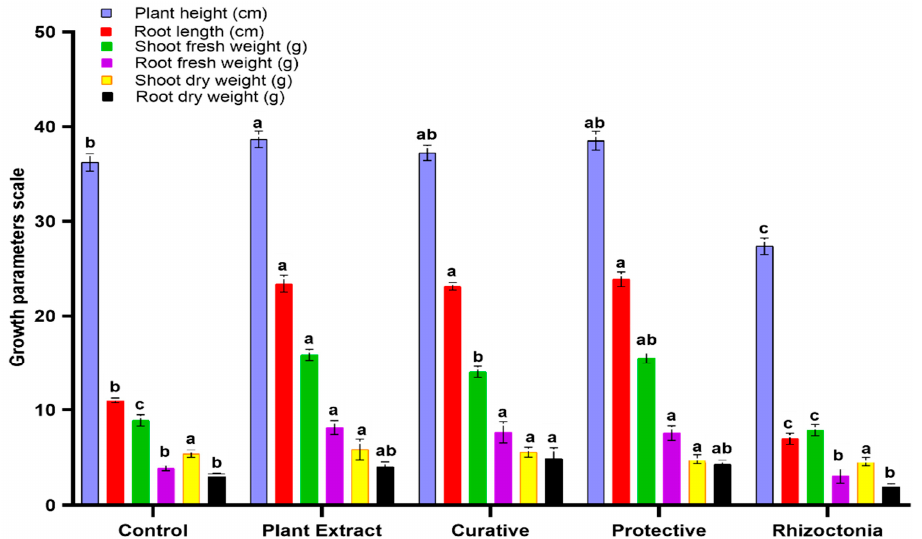
Figure 3. Effect of treatment with Chorisia speciosa extract on growth parameters of tomato plants. The different letters on top of the columns mean the data values were significantly different at p ≤ 0.05.